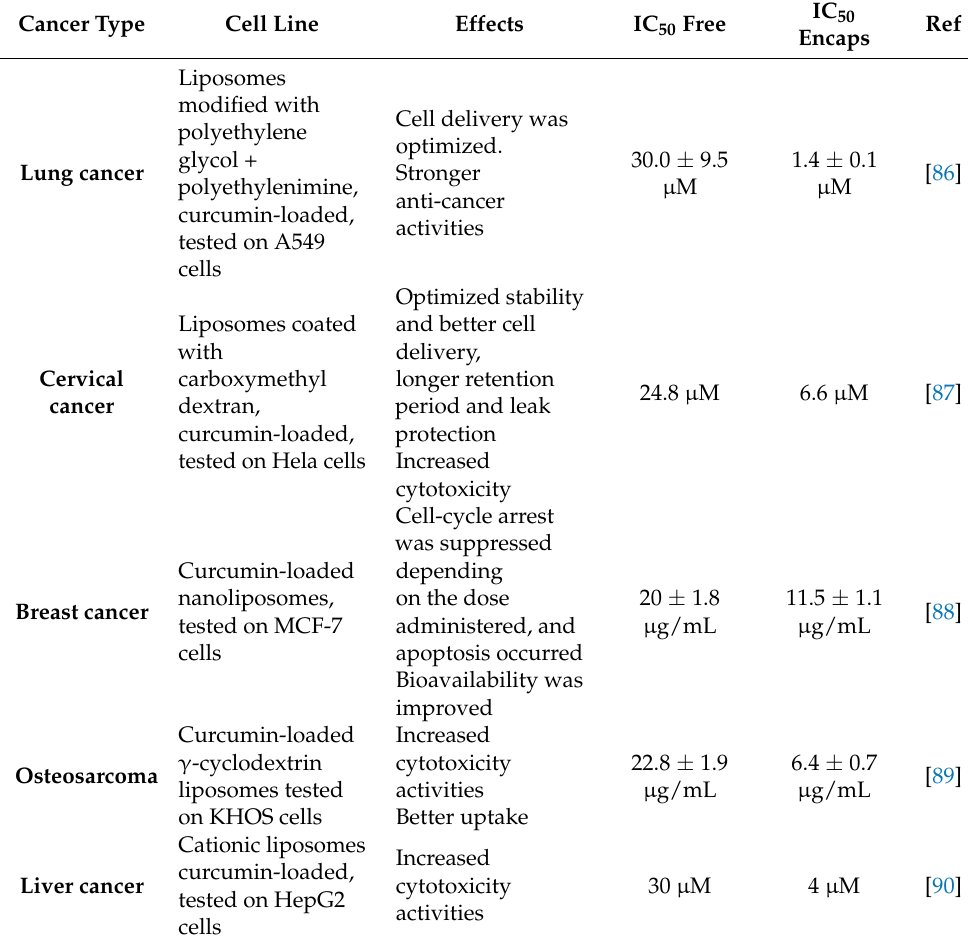
Table 2. Types of cancers and the effects of curcumin treatment encapsulated in liposomes. Cancer